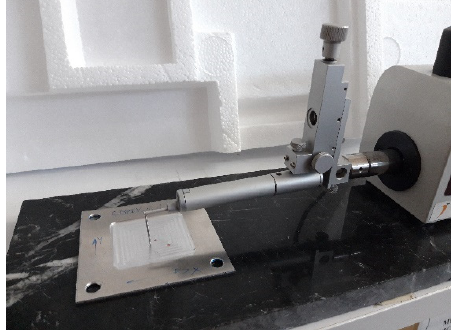
Figure 3. Measurement of final roughness in a sample.